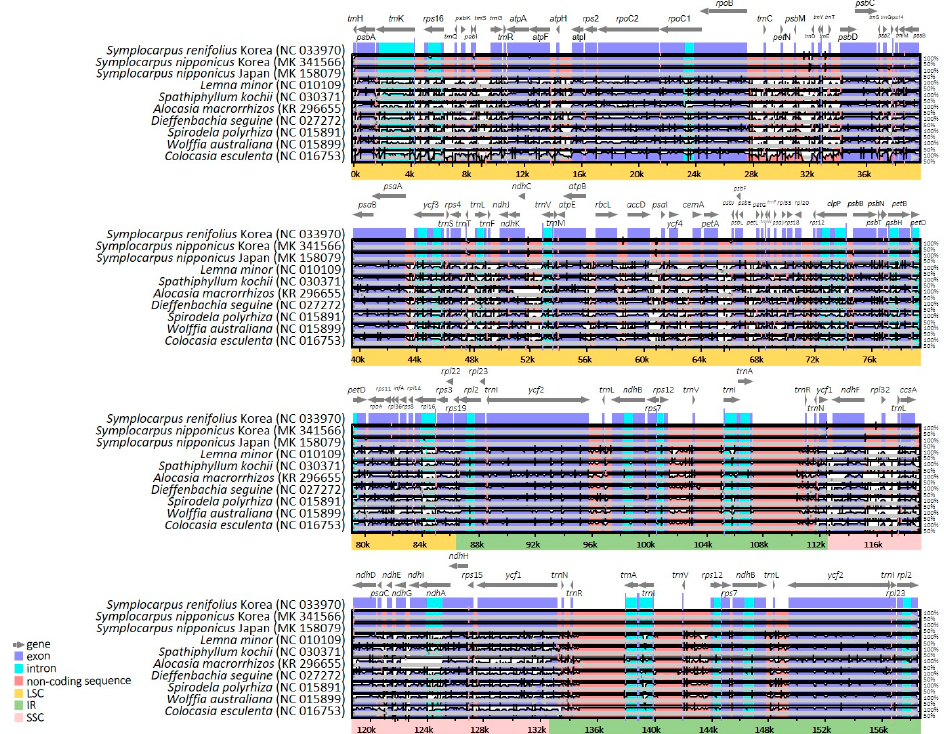
Figure 4. Alignment visualization of chloroplast genome sequences from nine representative species of Araceae. VISTA-based identity plots revealed the sequence identity of ten chloroplast genomes relative to the reference Symplocarpus renifolius . Vertical scale indicates the percent identity, from 50 to 100%. Coding and noncoding regions are in blue and pink, respectively. Gray arrows above the alignment indicate the position and direction of each gene.